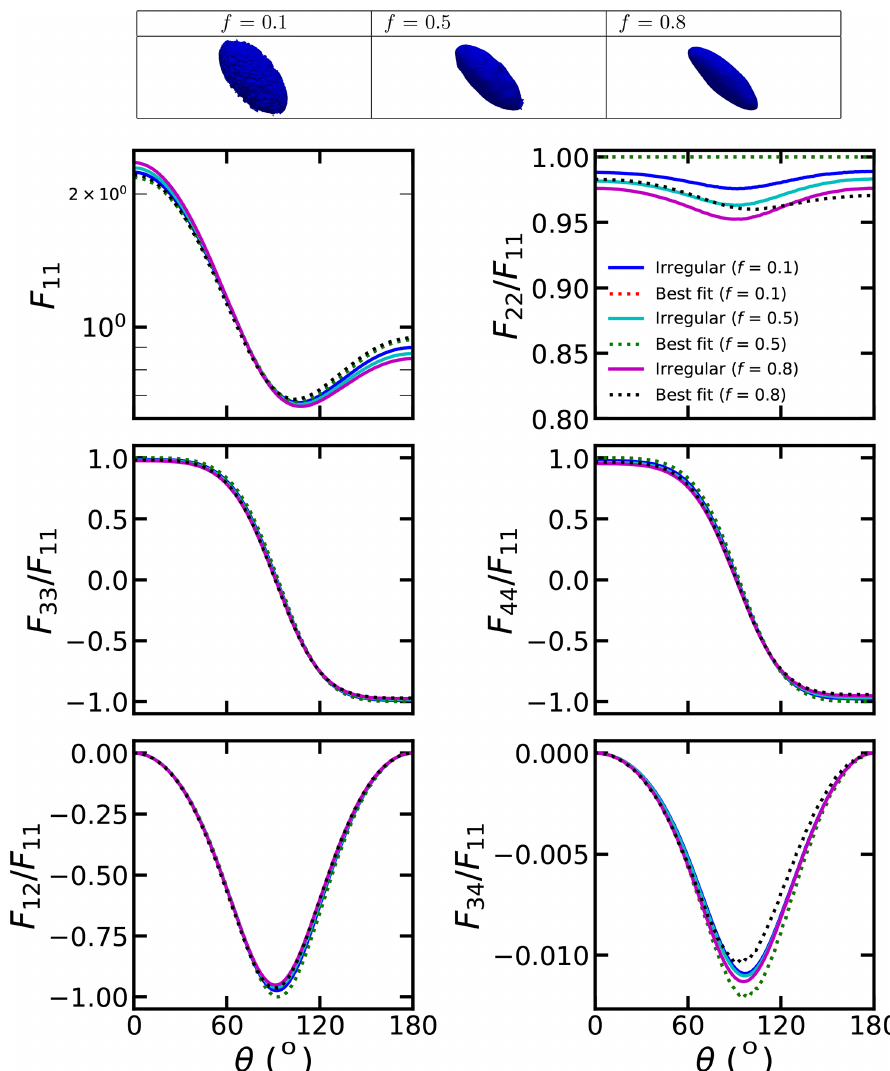
Figure 3. The scattering matrix of dust with irregular shapes, where the aspect ratio is 2 : 1 and d p = 0 . 2µm.